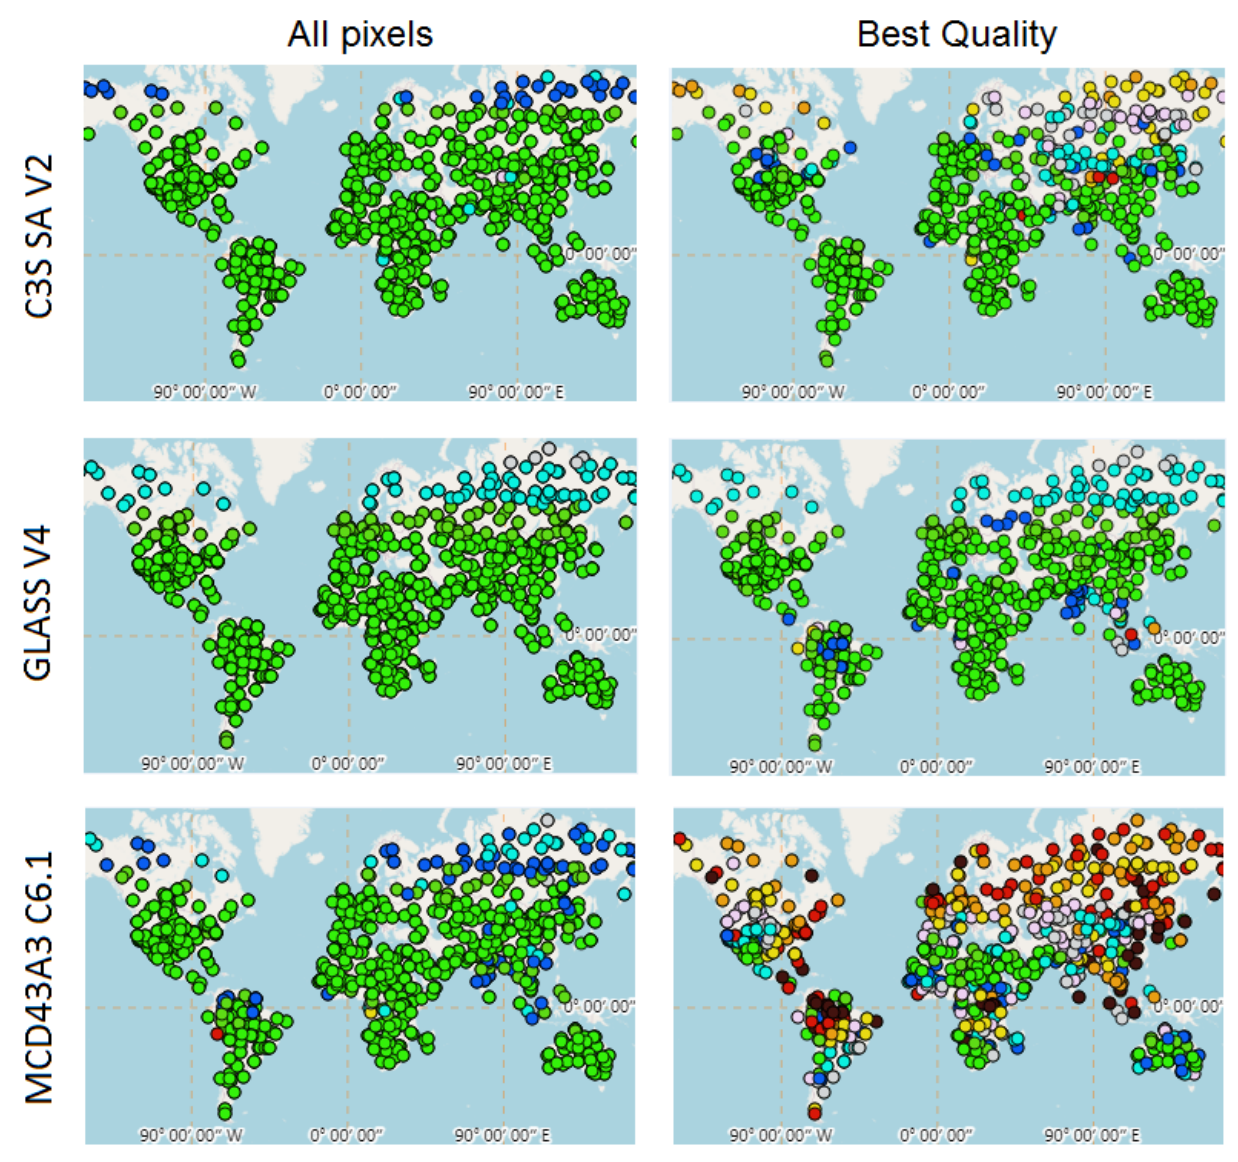
Figure 5. Global maps of the percentage of missing values for C3S V2 ( top ), GLASS V4 ( center ), and MCD43A3 C6.1 ( bottom ) for all pixels ( left ), and only best quality pixels ( right ) in the 2003 year, evaluated over the 720 LANDVAL sites.